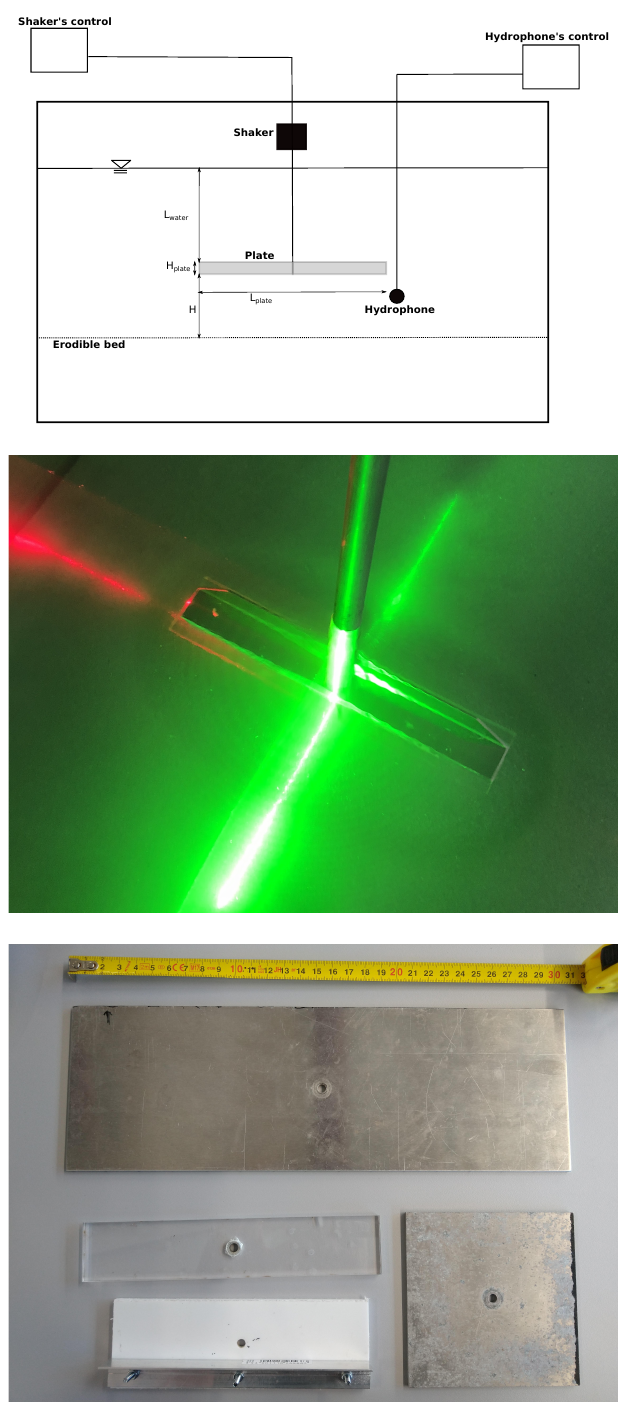
Fig. 1 : The experimental set up. Top panel: sketch of the set up with the main physical distances involved in the experiments. Central panel: detail of the experimental set up with the two per- pendicular laser sheets. Bottom panel: the plates used for this